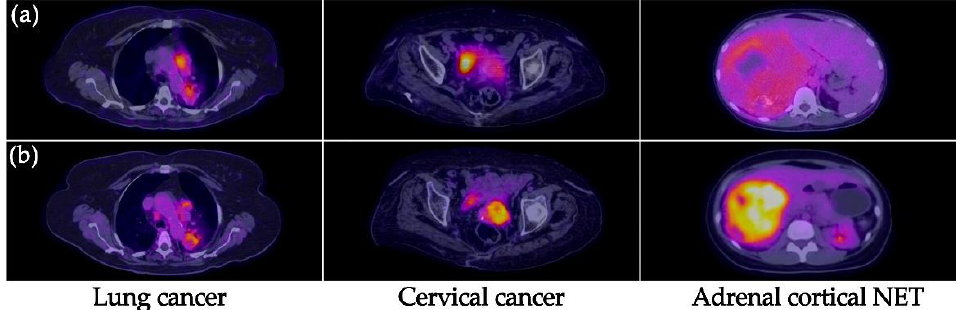
Figure 2. ( a ) [ 99m Tc]Tc-iFAP SPECT/CT and ( b ) [ 18 F]FDG PET/CT images of the primary tumors of three different types of cancers. All primary lesions show concordant uptake between both molecular imaging methods. [ 99m Tc]Tc-iFAP uptake was considerably lower regarding [ 18 F]FDG in patients with cervical cancer and neuroendocrine tumor (NET) of the adrenal cortex.